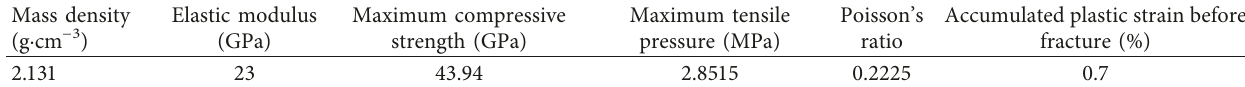
Table 5: Medium-grain sandstone blasting parameters.